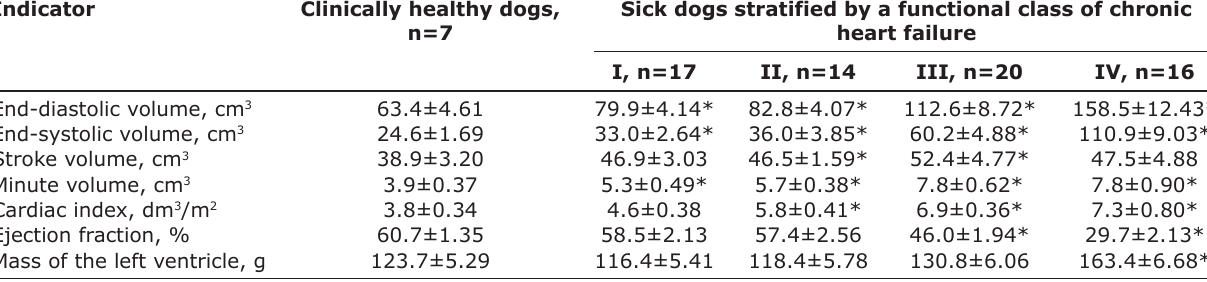
Table-2: Echocardiographic parameters of dogs with dilated cardiomyopathy, according to their functional class of heart failure, M±m, n=14-20. Indicator